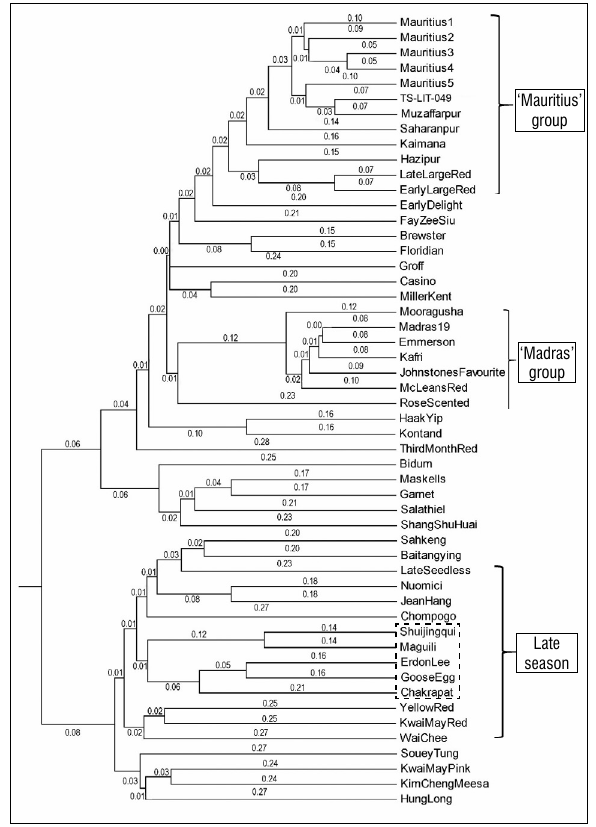
Figure 1: UPGMA (unweighted pair group method with arithmetic mean) dendrogram illustrating relationships between litchi cultivars and selections using sequence-related amplified polymorphism (SRAP) markers (Dice, CCC=0.945). Cultivars within the box with a dashed line produce typically large fruit with dark purple